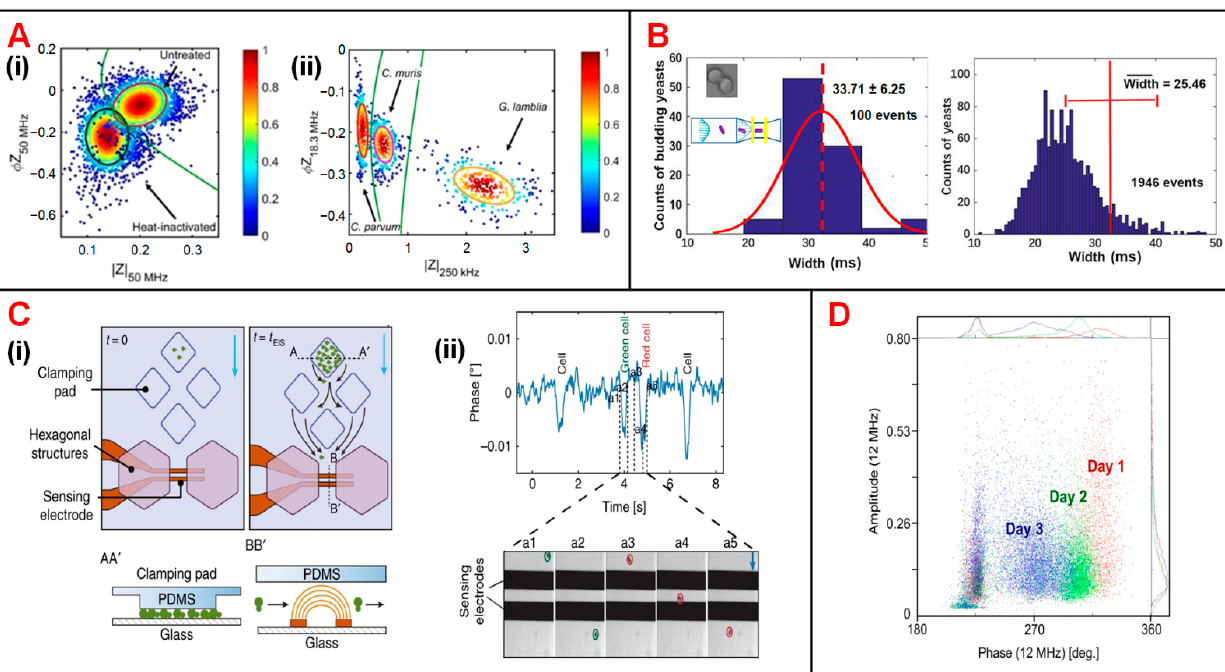
Figure 8. Microbial analysis using IFC devices. ( A ) ( i ) Scatter plot of phase ( Φ Z 50 MHz ) vs. amplitude (|Z 50 MHz |) for heat-inactivated and untreated C. parvum . ( ii ) Scatter plot of phase ( Φ Z 18.3 MHz ) vs. amplitude (|Z 250 kHz |) for C. parvum , C. muris and G. lamblia . Reproduced from [136] with the permission from Nature. ( B ) Histograms of particle counts in distribution of signal pulse width measured at 1 MHz. Width refers to the time that yeast cells take to pass through the sensing electrodes. Reproduced from [139] with the permission from American Chemical Society. ( C ) ( i ) Schematics of an IFC device used for long-term budding yeast culturing and growth-rate measurement. ( ii ) Signal phase changes corresponding to five events that yeast cells passing through the impedance sensing electrodes. Reproduced from [137] with the permission from Nature. ( D ) Scatter plot of impedance signal amplitude vs. phase at 12 MHz for yeast population during three-day brewing process. Reproduced from [138] with the permission from Springer.